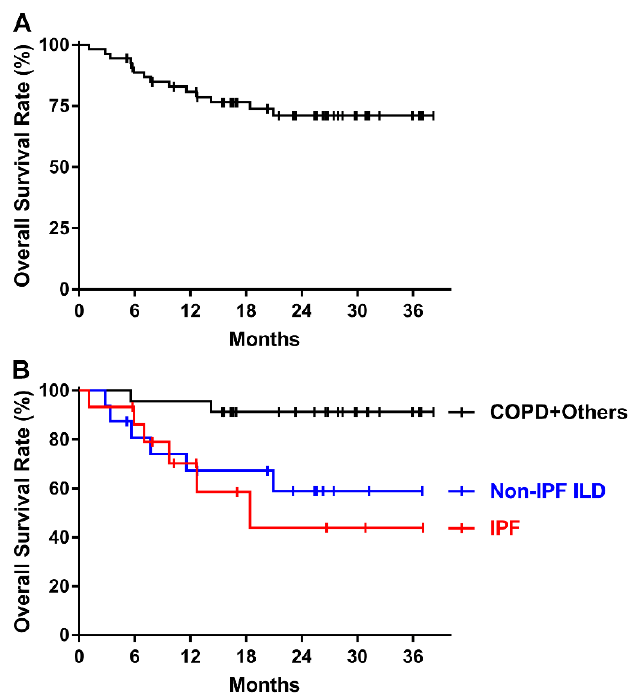
Figure 3. ( A ) Overall survival of all patients. ( B ) Overall survival according to underlying lung dis- ease.